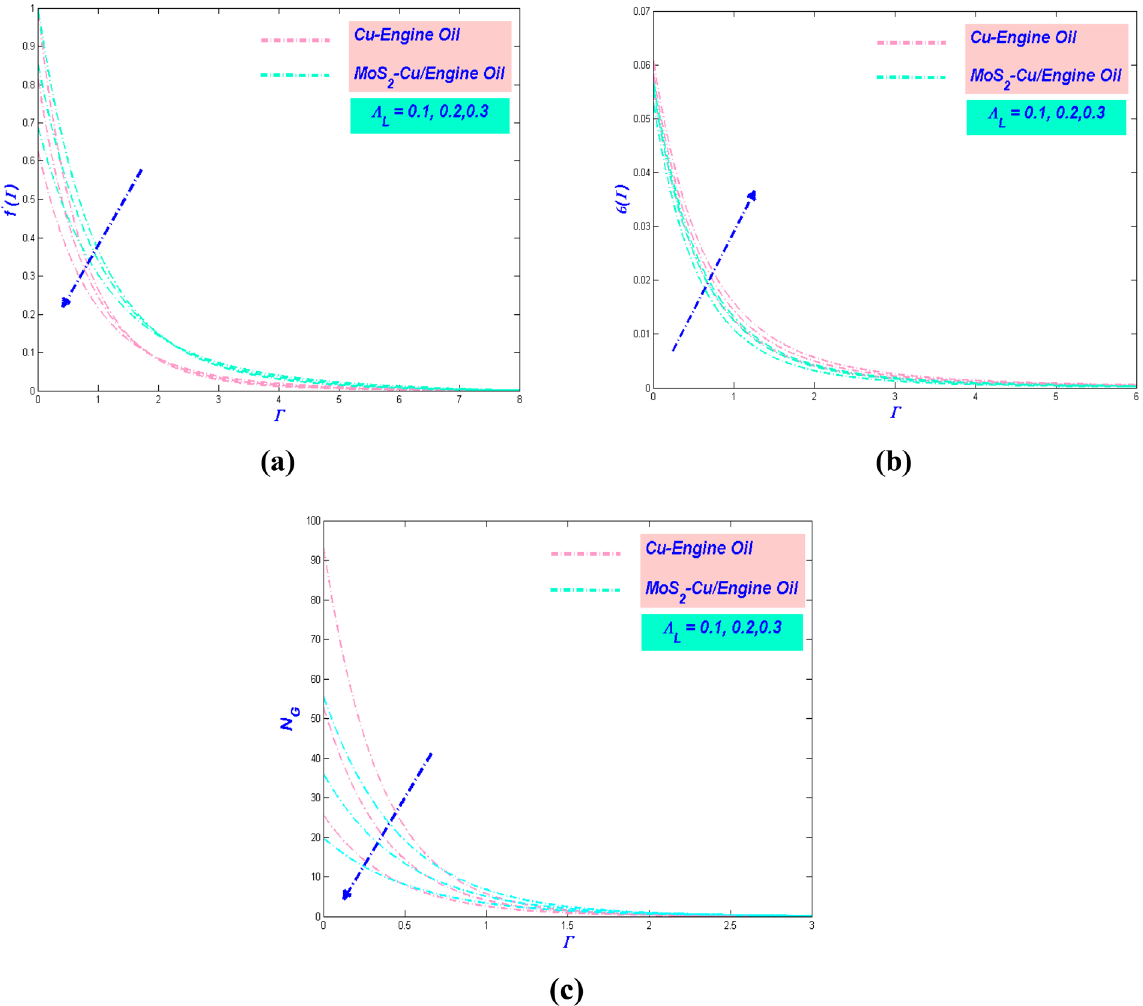
Figure 9. ( a ) Velocity, ( b ) temperature and ( c ) entropy variations with (cid:31) L .